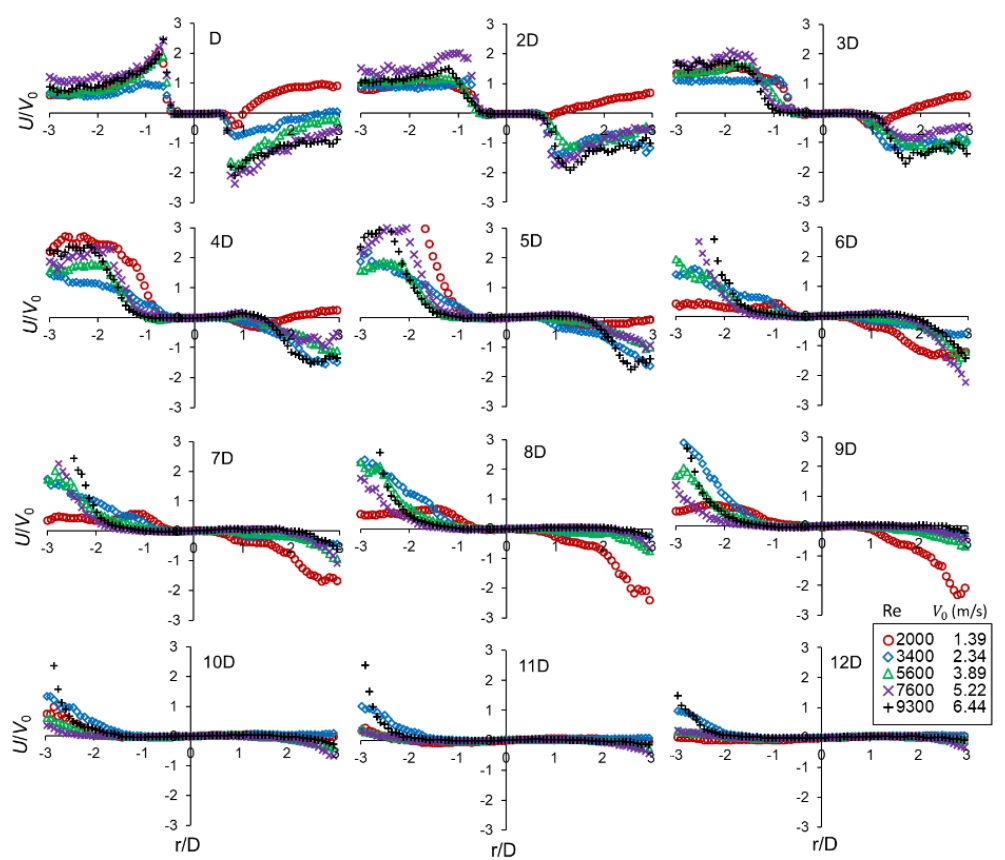
Figure 6. Normalized spanwise velocity profiles at different downstream distance.